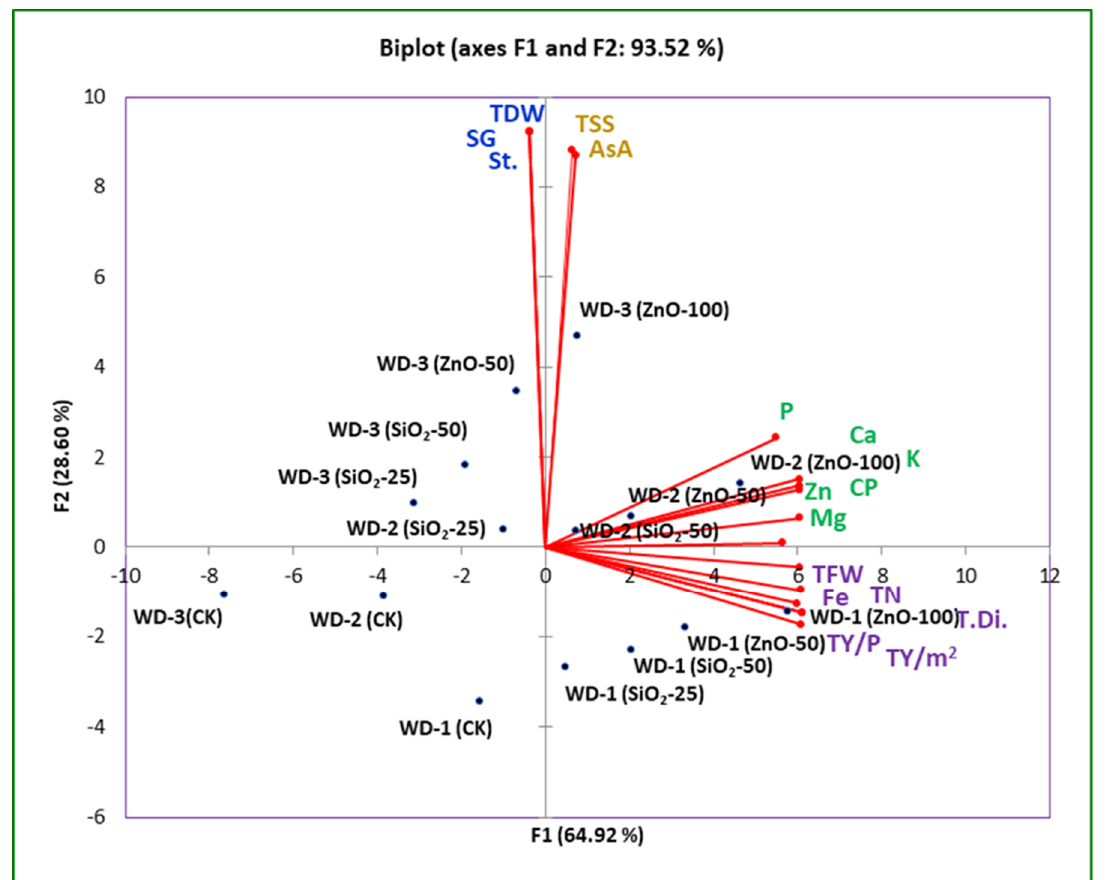
Figure 3. Biplot of the first two principal components for the yield parameters and quality (physical and chemical) traits of potato tubers. The yield parameters included tuber number (TN), tuber fresh weight (TFW), tuber yield per plant (TY/p), and tuber yield per m 2 (TY/m 2 ). The physical parameters comprised tuber diameter (TDi.), tuber dry weight (TDW), and specific gravity (SG). The chemical attributes include ascorbic acid (ASA), total soluble solids (TSS), crude protein (CP), starch (St.), and minerals (Ca 2+ , K + , P, Mg 2+ , Fe 2+ , and Zn 2+ ). CK (control), WD-1 (100% ETc), WD-2 (75% ETc), and WD-3 (50%